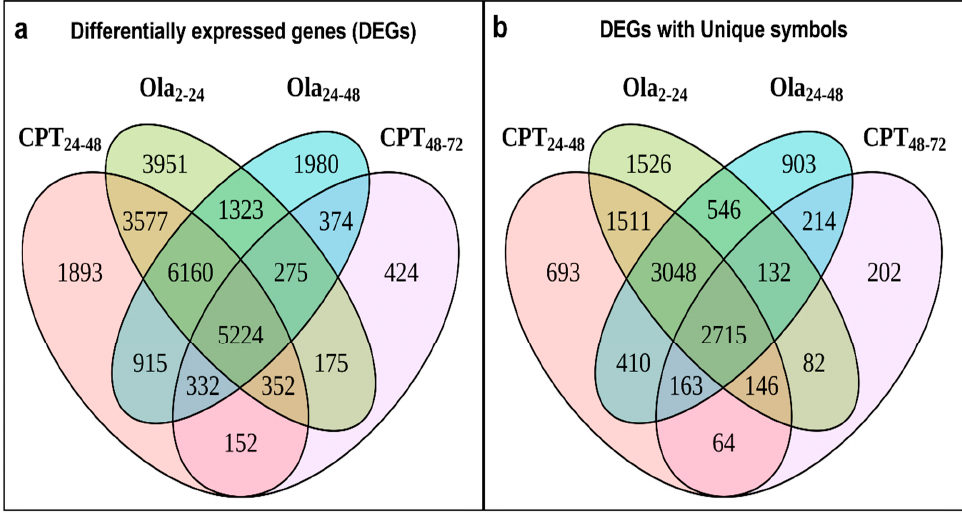
Figure 4. Overlap in significantly (padj < 0.1) differentially expressed genes (DEGs) of sterlet ( A. ruthenus ) between treatments ( a ). Only DEGs with unique gene symbols ( b ). The DEGs that were detected with a lower mRNA abundance in the treatment groups compared with the control (log2 fold-change < 0) were referred to as “downregulated”, and those that showed a higher abundance in the treatment compared with the control